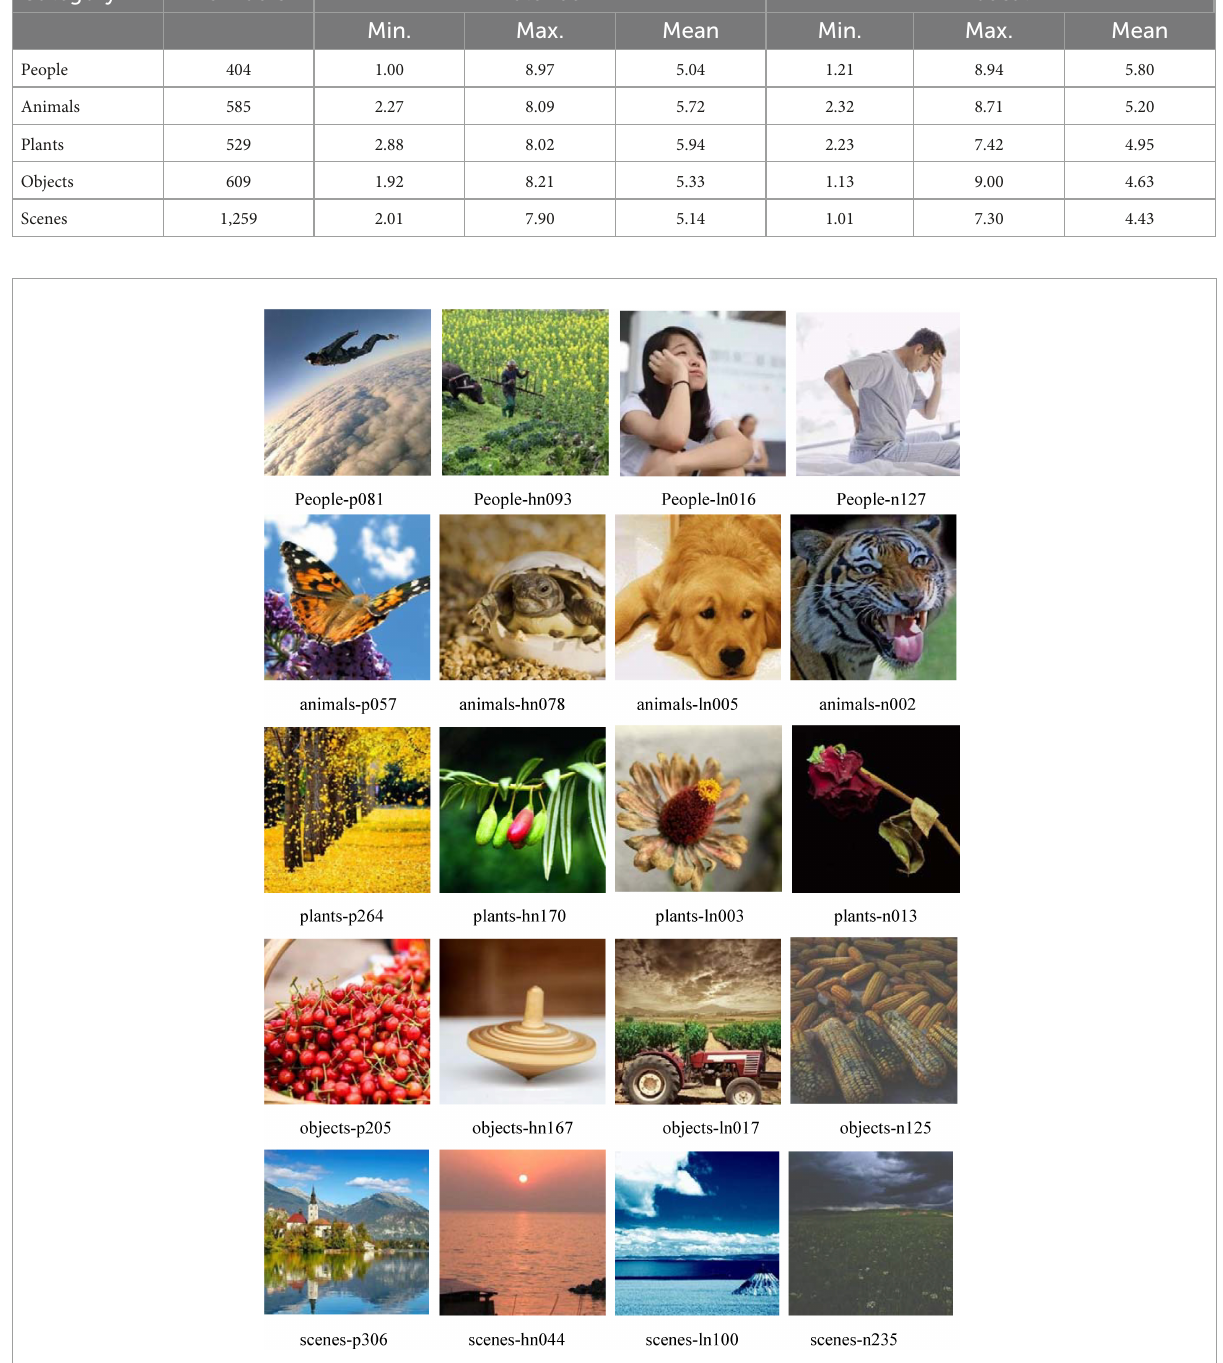
FIGURE3 Example of the material library. In HDRPS, images are named according to content category, valence label, and number. For example, people-n081 represents the 81st positive picture of the people category. The rating for valence (V), arousal (A) are as follow: people-p081, V = 6.65, A = 7.30; people-hn093, V = 5.84, A = 4.96; people-ln016, V = 4.57, A = 3.94; people-n127, V = 2.67, A = 4.17; animals-p057, V = 6.11, A = 6.14; animals-hn078, V = 5.76, A = 4.98; animals-ln005, V = 4.46, A = 4.03; animals-n002, V = 3.38, A = 7.97; plants-p264, V = 6.70, A = 6.21; plants-hn170, V = 5.89, A = 5.03; plants-ln003, V = 4.05, A = 3.98; plants-n013, V = 3.47, A = 3.73; objects-p205, V = 6.74, A = 5.08; objects-hn167, V = 5.80, A = 4.98; objects-ln017, V = 4.45, A = 5.23; objects-n125, V = 2.78, A = 4.88; scenes-p306, V = 6.92, A = 6.16; scenes-hn044, V = 5.93, A = 4.83; scenes-ln100, V = 4.69, A = 4.02; scenes-n235, V = 2.98, A =